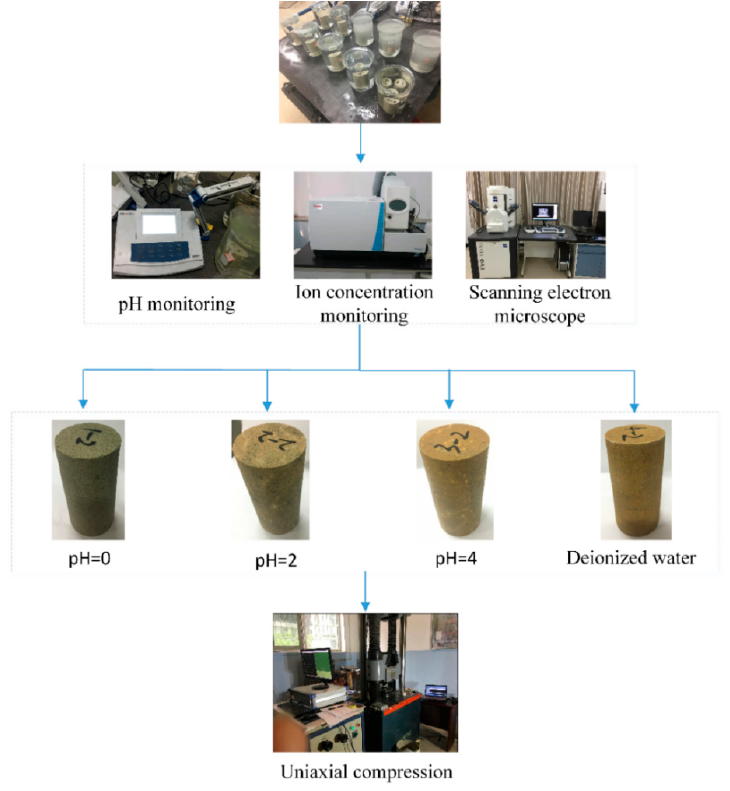
Figure 1. Acidizing tests on lamprophyre.